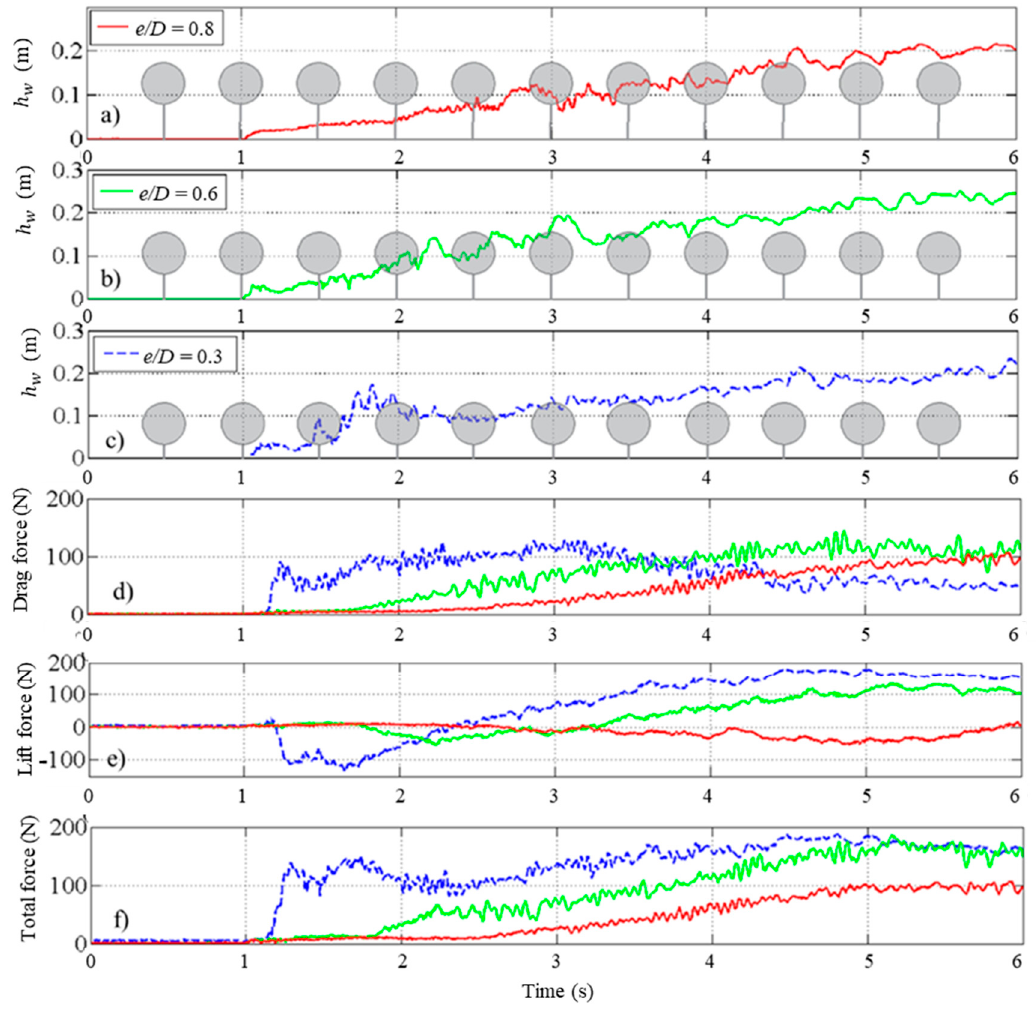
Figure 5. Time-history of the water level and the drag and lift force component measurements for the dry bed condition and an impoundment depth h = 40 cm: ( a ) water level with e/D = 0.8, ( b ) water level with e/D = 0.6, ( c ) water level with e/D = 0.3, ( d ) drag force time-history for e/D = 0.3, 0.6, and 0.8, ( e ) lift force time-history for e/D = 0.3, 0.6, and 0.8, and ( f ) total force for e/D = 0.3, 0.6, and 0.8.